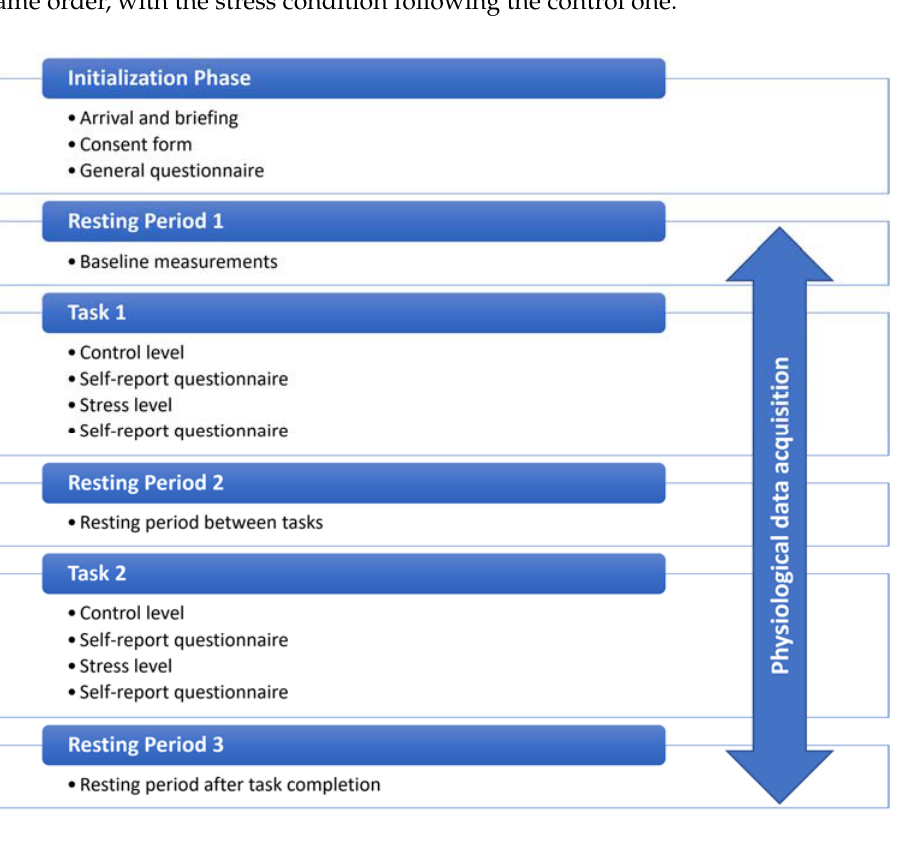
Figure 5. The schematic diagram of the experimental